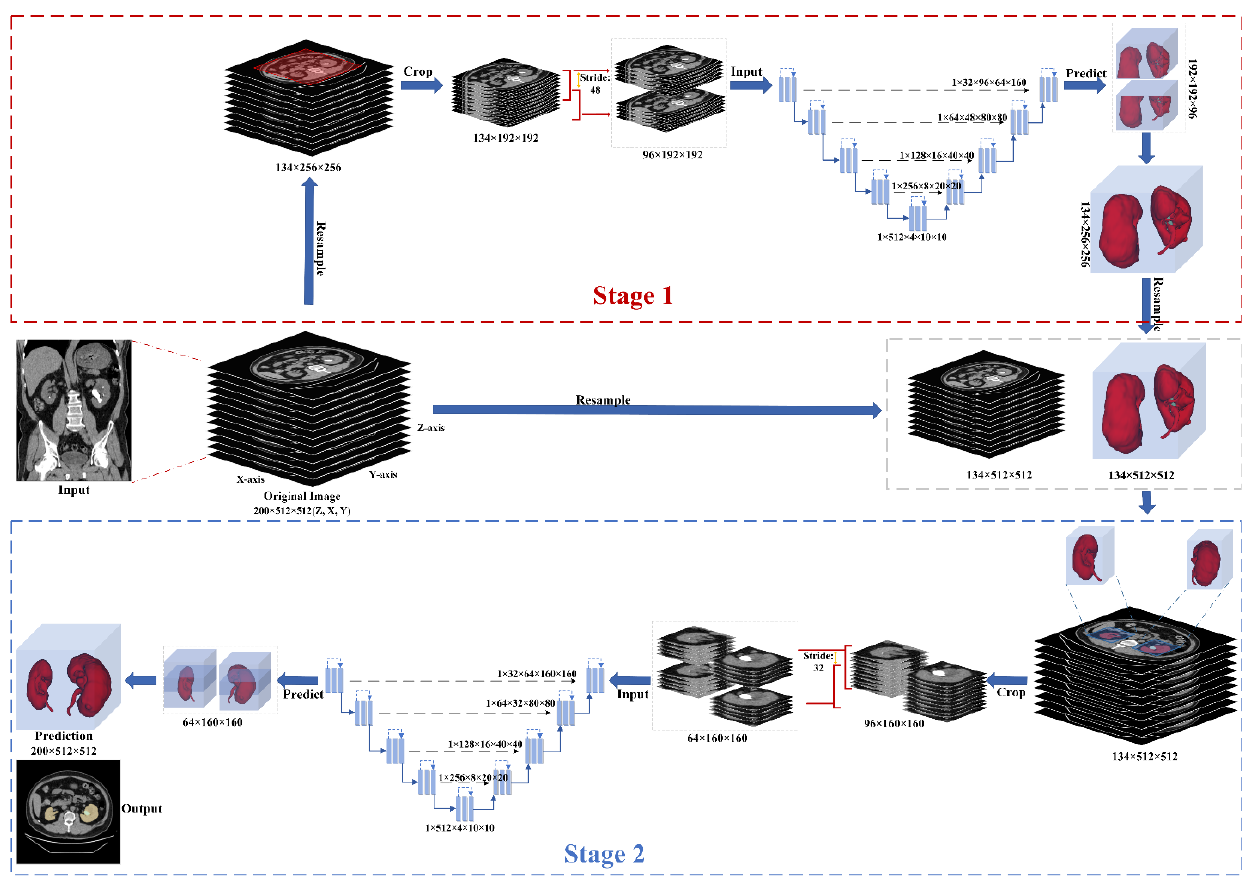
Figure 3. The proposed training scheme consists of two segmenting stages. In the first stage, the original image has been resampled and cropped into a single region covering both the kidneys. This cropped region is further clipped into cubes for the first segmentation network. The second stage receives the input based on the first stage and original image, which the second segmentation network could use for the fine kidney segmentation and kidney stone detection.